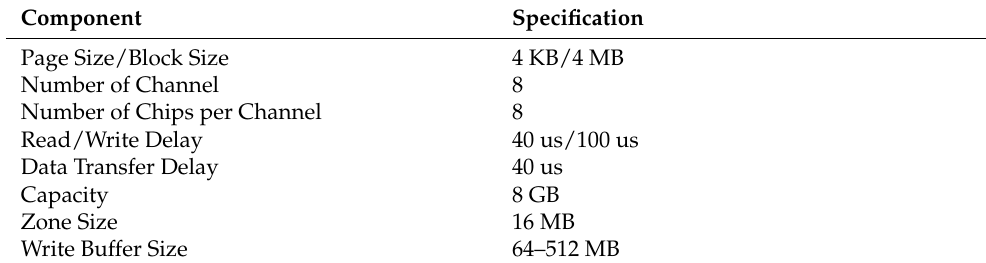
Table 2. ZNS SSD Specifications.